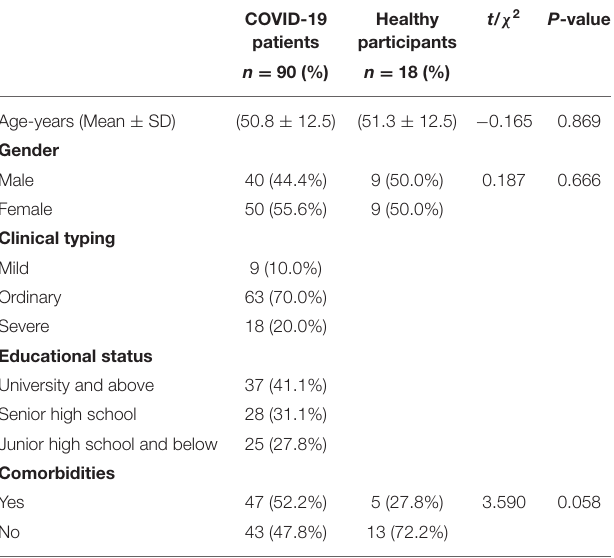
TABLE 3 | The baseline characteristics of patients with COVID-19 and healthy participants.